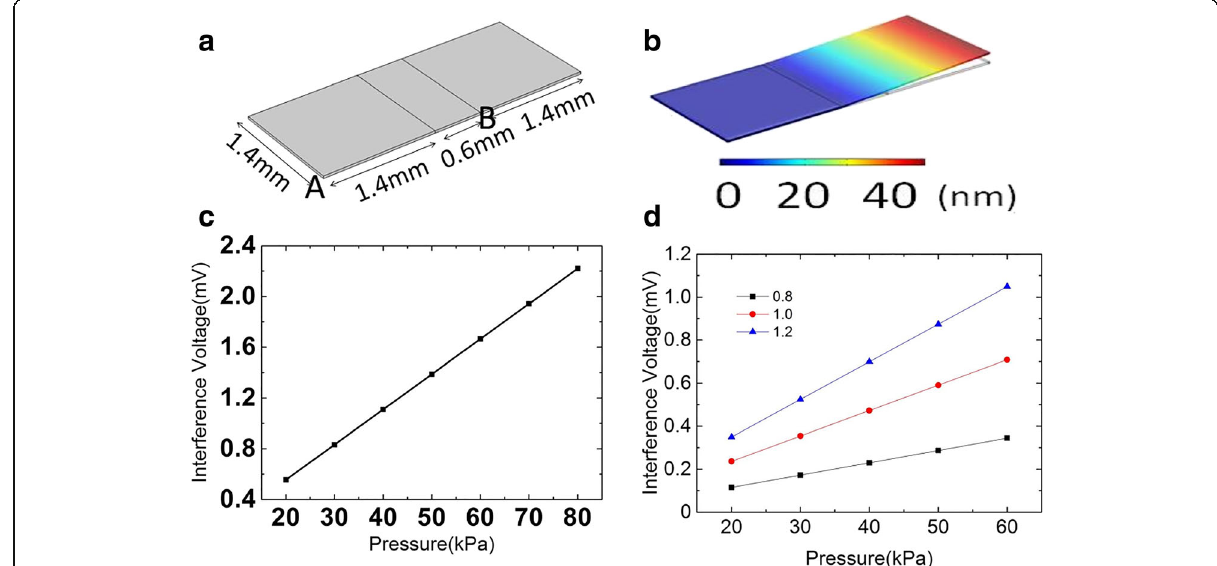
Fig. 5 a Physical dimensions used for theoretical simulation. b Displacement and c liner curve-fitting between interference voltage and applied pressure with an array size of 1.4 mm. d Obtained results using array sizes of 0.8, 1.0, and 1.2 mm,